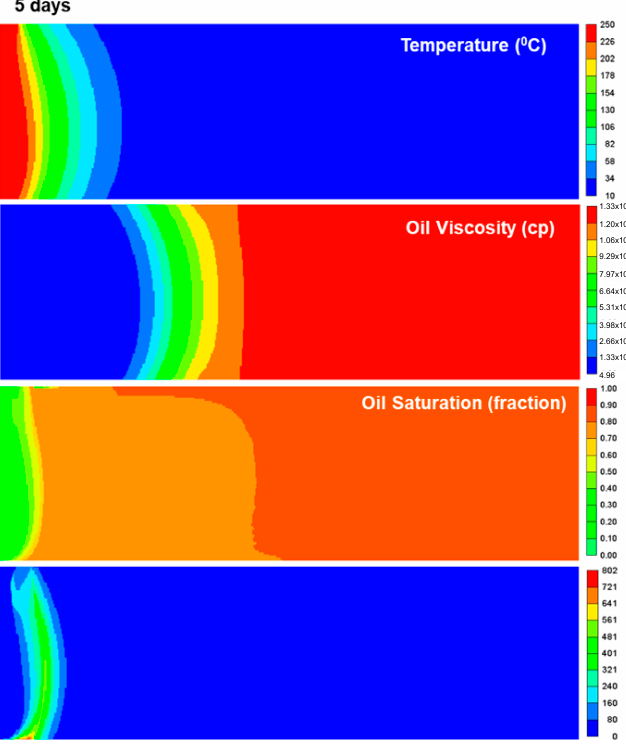
Figure 23. 2D images of the temperature, oil viscosity, oil saturation and oil phase mobility distributions of the HE model after 5 days of steam injection. The height of the image has been exaggerated by two times.